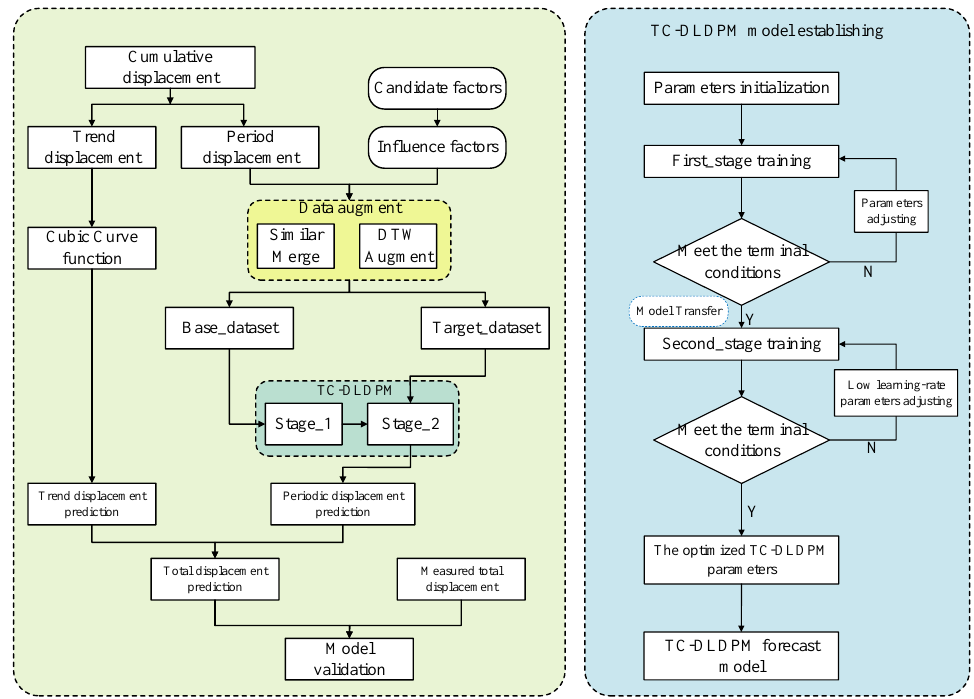
Figure 1. Flow chart of cumulative landslide displacement prediction.